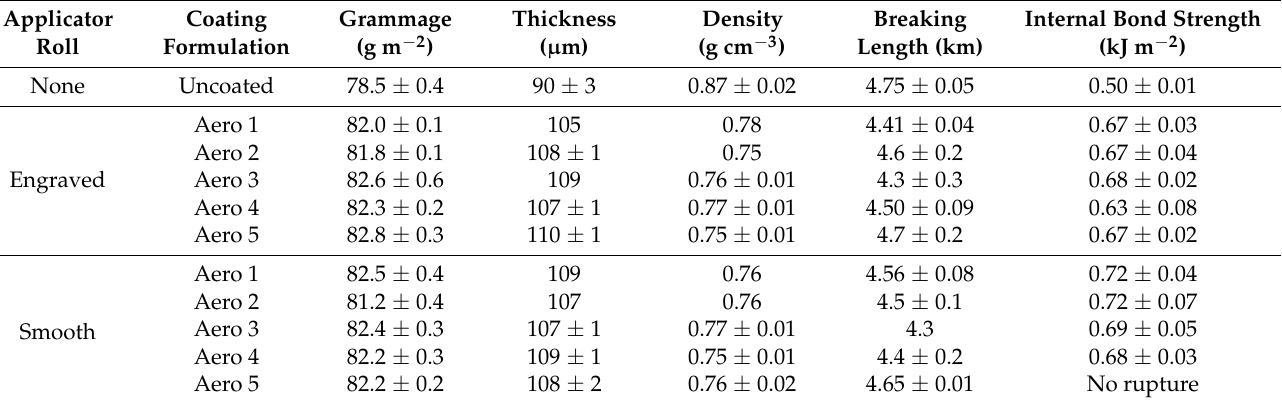
Table 5. Key properties of the sheets coated with airtight formulations. The amplitude of the intervals equals twice the standard